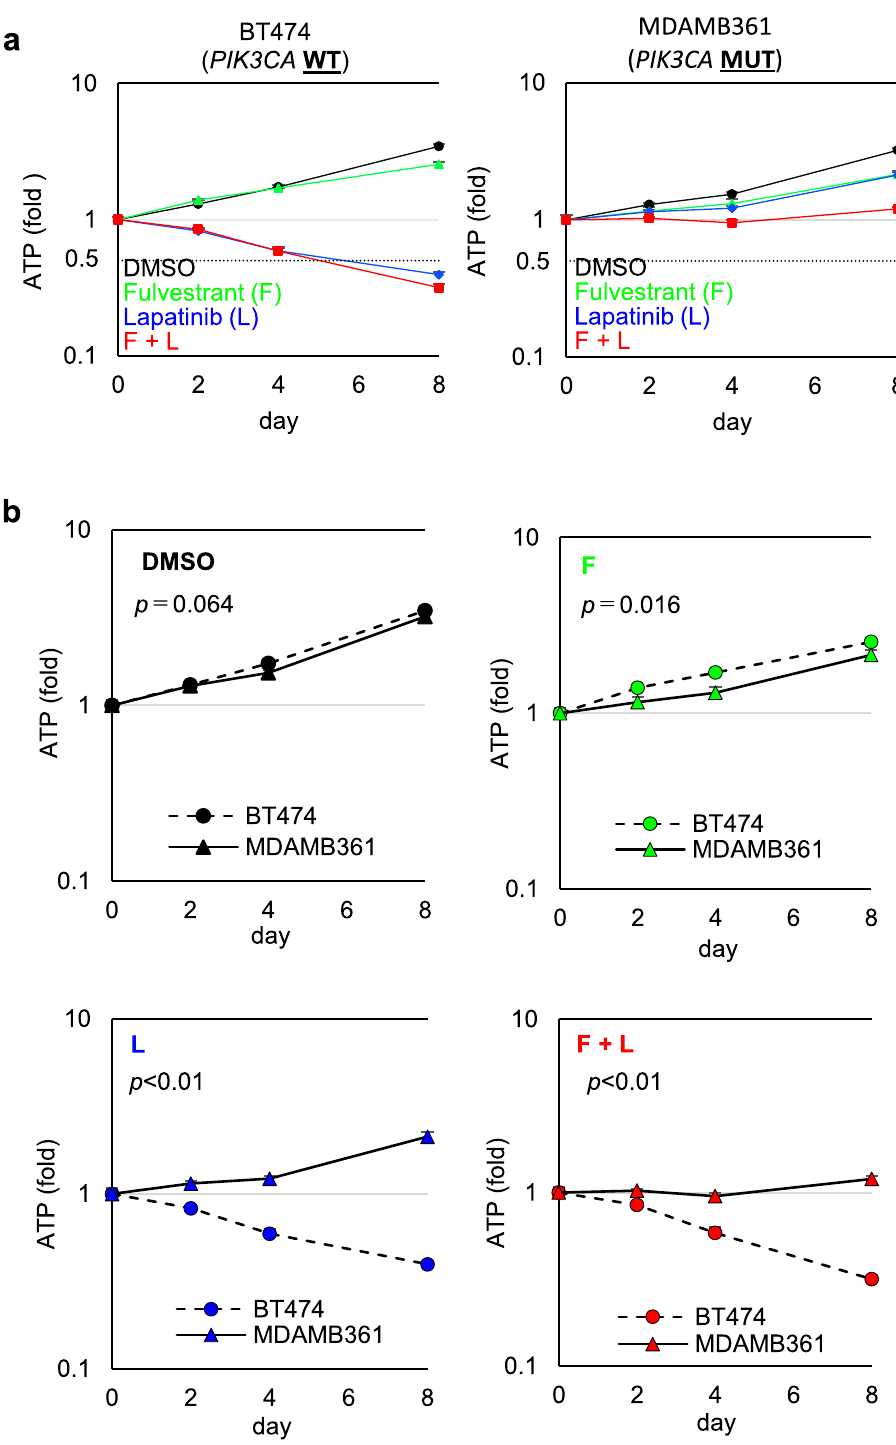
Figure 2. The antiproliferative effect of treatment with fulvestrant and lapatinib is limited in MDA-MB-361 cell line. ( a ) Antiproliferative activity of fulvestrant and lapatinib, alone and in combination, in ER+/HER2+ breast cancer cell lines with and without PIK3CA mutations. BT474 (left) and MDA-MB-361 (right) cells were used as representative PIK3CA-wild-type and PIK3CA-mutant ER+/HER2 breast cancer cell lines, respectively. Cells were treated with DMSO (black), fulvestrant (100 nM, green), or lapatinib (100 nM, blue), alone and in combination (red), for 0, 2, 4, and 8 days (mean ± standard deviation [SD; n = 3]). Relative levels of ATP were calculated by chemiluminescence assay and compared with the chemiluminescence of DMSO on day 0. ( b ) Comparison of the effect in each drug treatment between BT474 and MDA-MB-361 cell lines. Differences on day 8 were analyzed using Student’s t-test. The data represent the mean ± SD (n = 3). F, Fulvestrant; L,